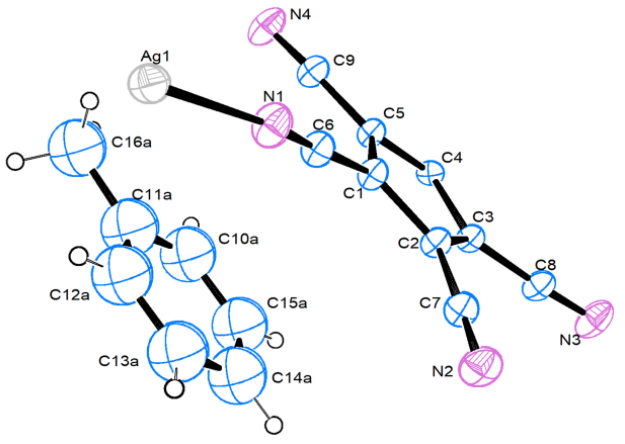
Figure 4. The asymmetric unit of compound 4 (only one orientation of the toluene solvent shown).